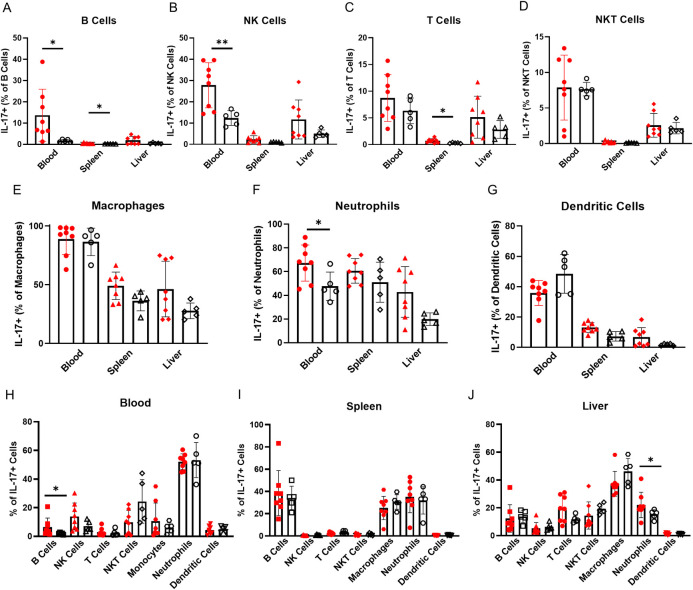
IL-17 expression is increased in alcohol dependent compared to control mice.(A-G) Expression of IL-17 by (A) B cells, (B) NK cells, (C) T cells, (D) NKT cells, (E) macrophages, (F) neutrophils and (G) dendritic cells in alcohol dependent (red, solid fill) and non-dependent (black outline, white fill) mice. (H-J) Immune cells as percentages of all IL-17 producing CD45+ cells in (H) blood, (I) spleen and (J) liver isolated from dependent and non-dependent mice. *, p<0.05; **, p<0.01 analyzed by Mann-Whitney U test; n = 5–8.